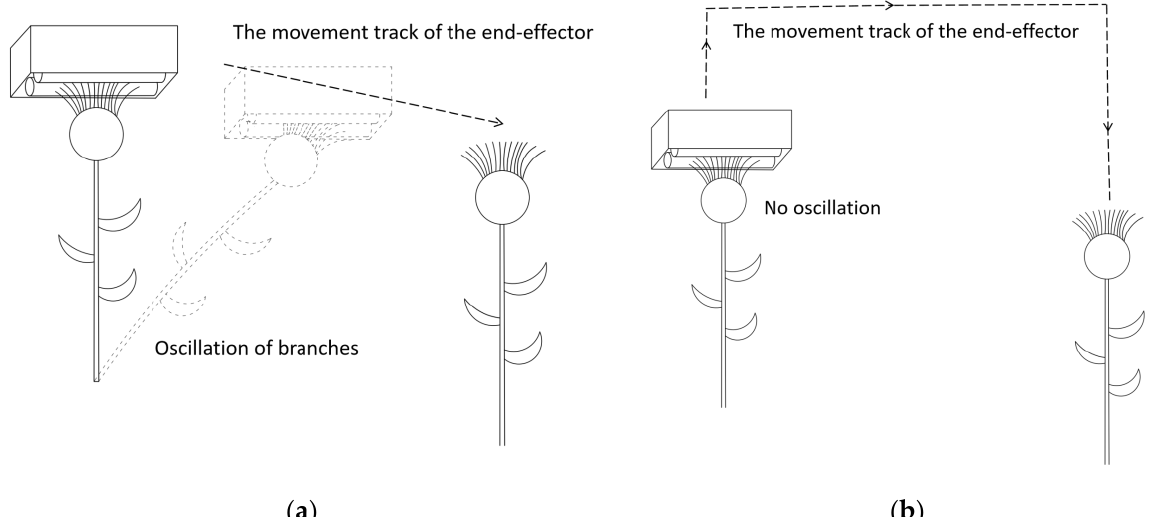
Figure 5. Comparison of two kinds of picking tracks: ( a ) Effectiveness of straight-line track; ( b ) Effectiveness of ∩ -shaped track.